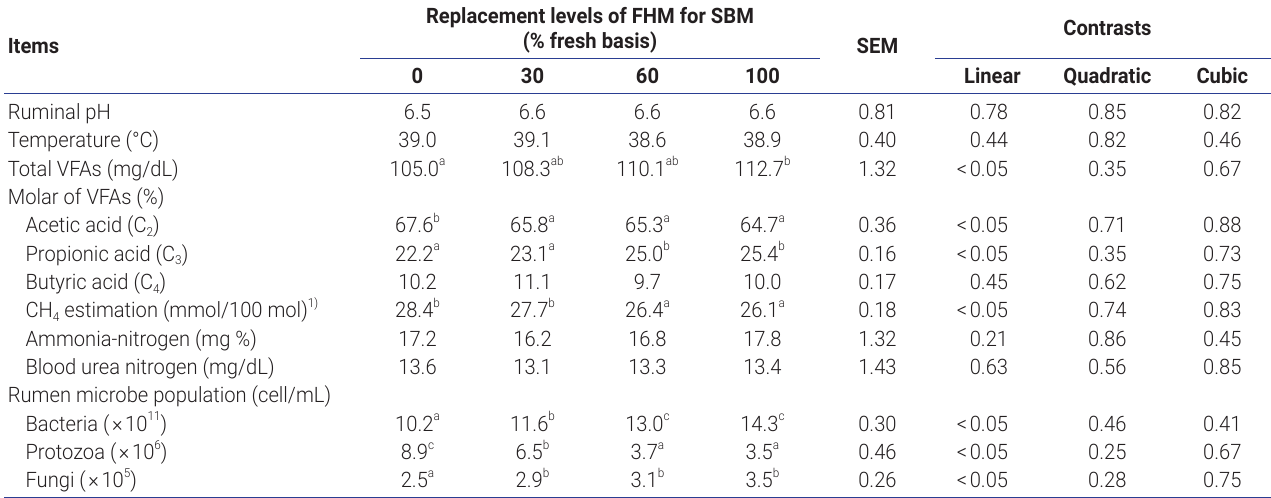
Table 3. Flemingia as a protein source fodder on fermentation characteristics, blood urea nitrogen and microbial population in beef cattle